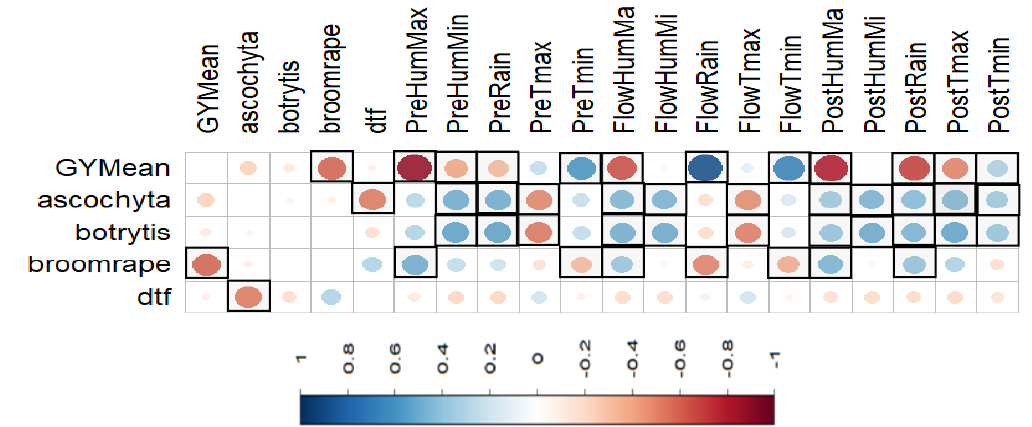
Figure 7. Graphical representation of the effects of climatic parameters and of disease incidence on grain yield, and among them. Size of the dot indicates its effect on the trait, blue when positive, red when negative. The statistically significant ones are highlighted.